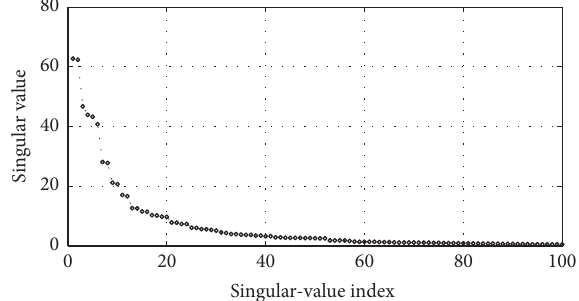
Figure 9: Singular